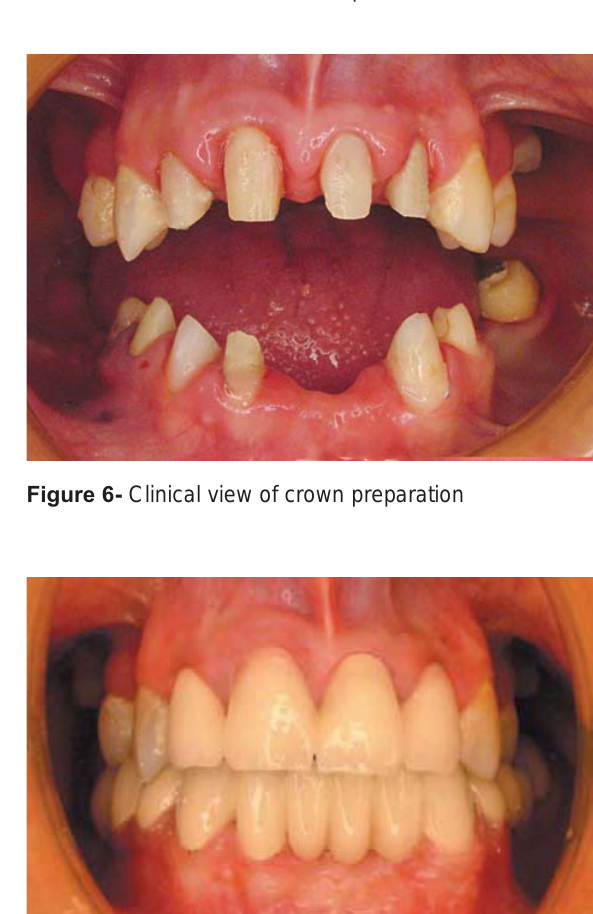
Figure 5- Clinical view of the bondable polyethylene reinforcement fiber (Ribbond) in position